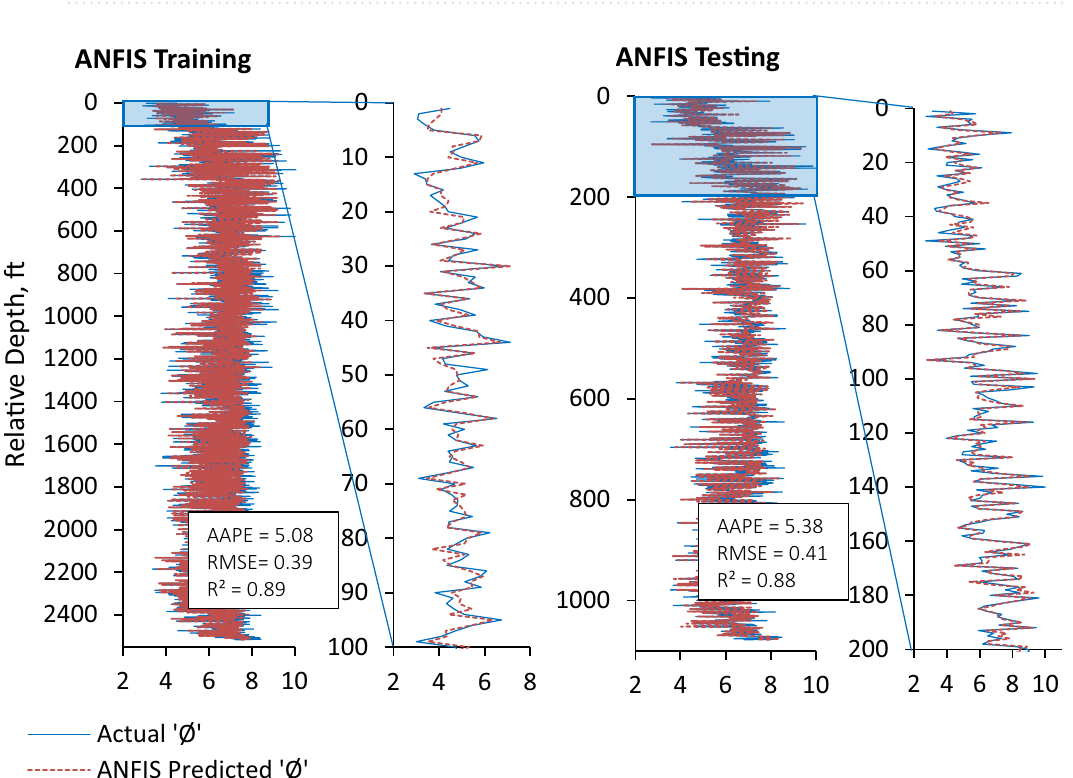
Figure 11. Comparison of training and testing results of ANFIS model with actual Φ NMR